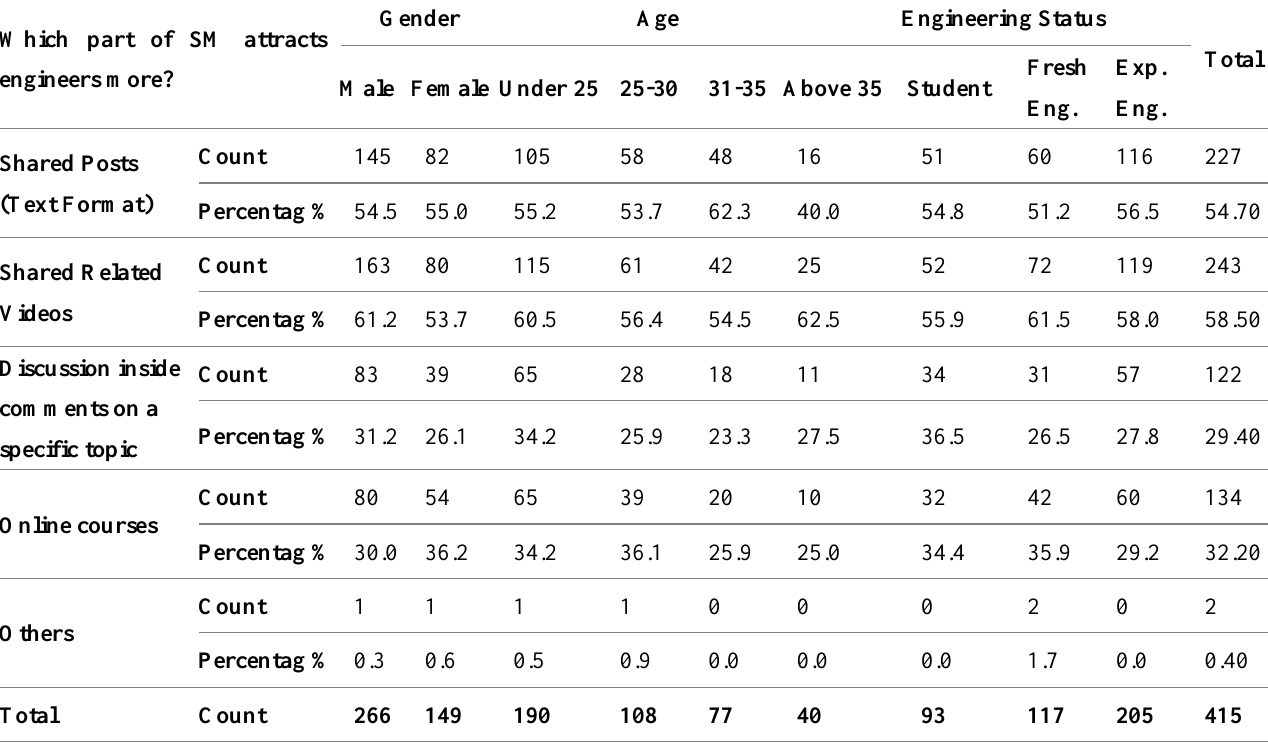
Table 4. Different Parts of SM Which Used by